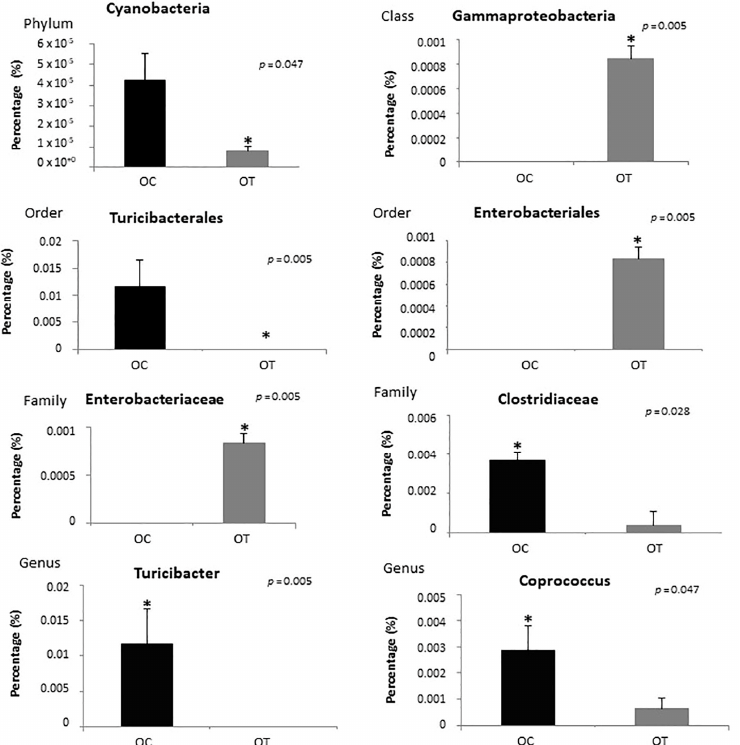
Figure 6. Analysis of the distribution of bacteria in the obese control (OC) and obese treated (OT) groups according to phyla, class, order, family and genus. * Statistical significance. Analysis of the distribution of bacteria in the lean treated group showed an increase in bacteria in the Tenericutes phylum ( p = 0.028); Enterobacteriales order ( p = 0.005); Bacteroidaceae ( p = 0.028), Prevotellaceae ( p = 0.028), and Enterobacteriaceae families ( p = 0.005); and Bacteroides ( p = 0.028) and Lactococcus ( p = 0.019) genera compared to the control group. There was also a decrease in the Turicibacter genus ( p = 0.005) and Sutterella genus ( p = 0.009) in the treated group (Figure 7).